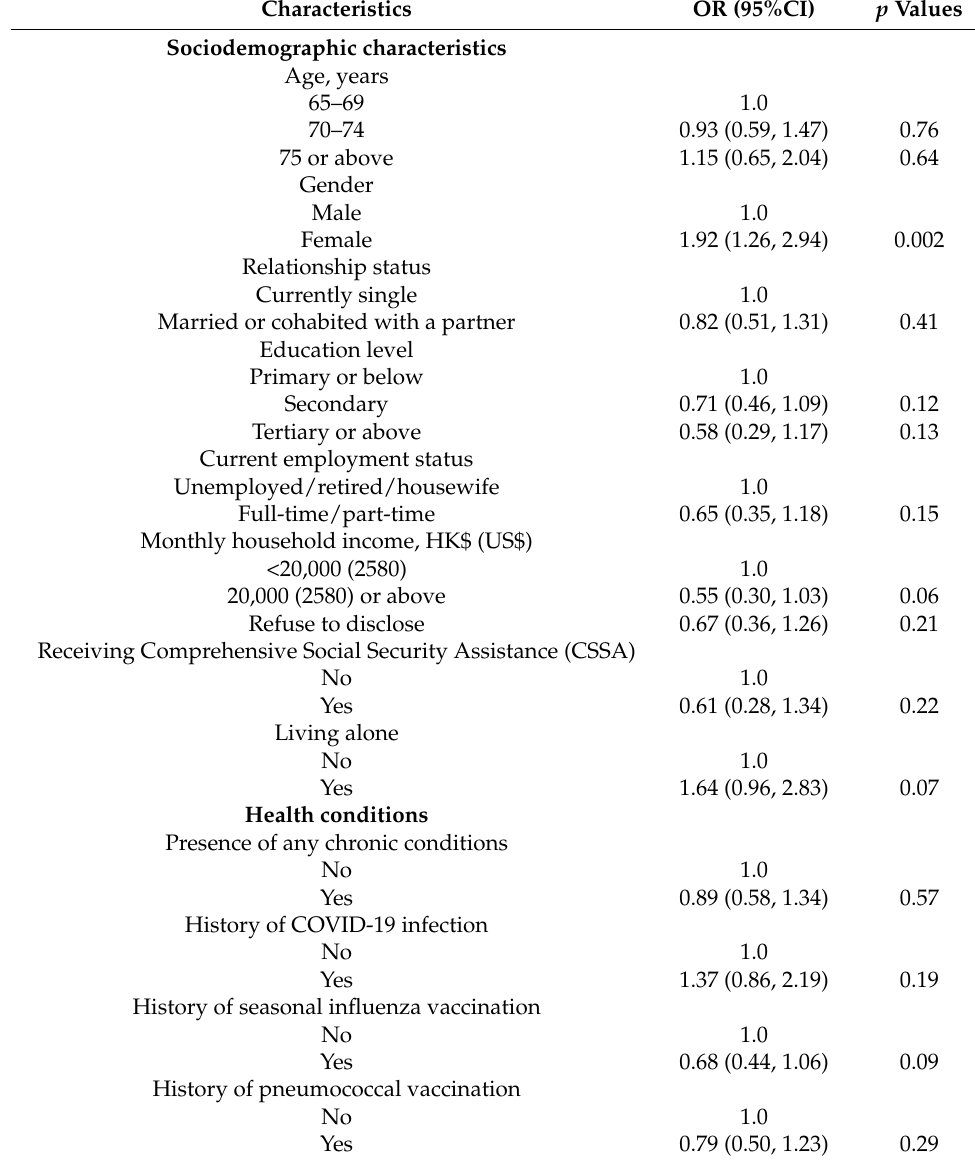
Table 3. Associations between background characteristics and hesitancy to receive the second COVID- 19 vaccine booster